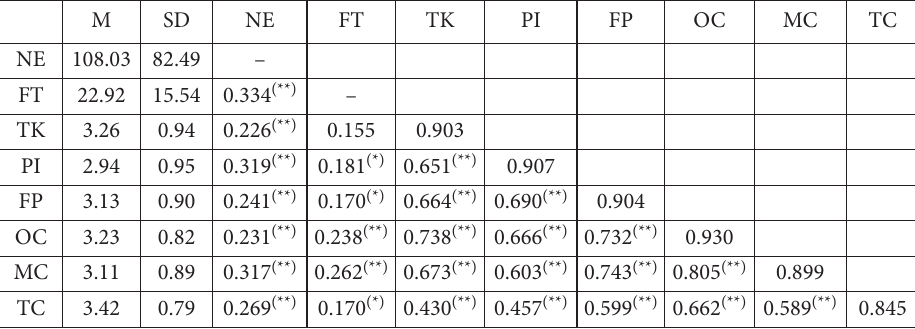
Table 1. Descriptive statistics, Cronbach’s alpha and correlations among study